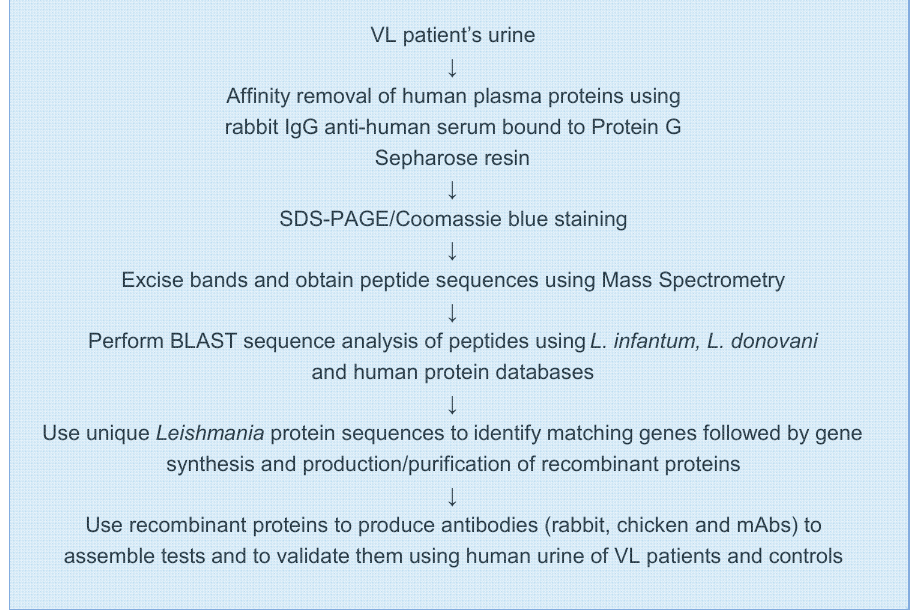
Figure 2. Experimental approach used for the discovery of L. infantum/L. donovani biomarkers and test development.